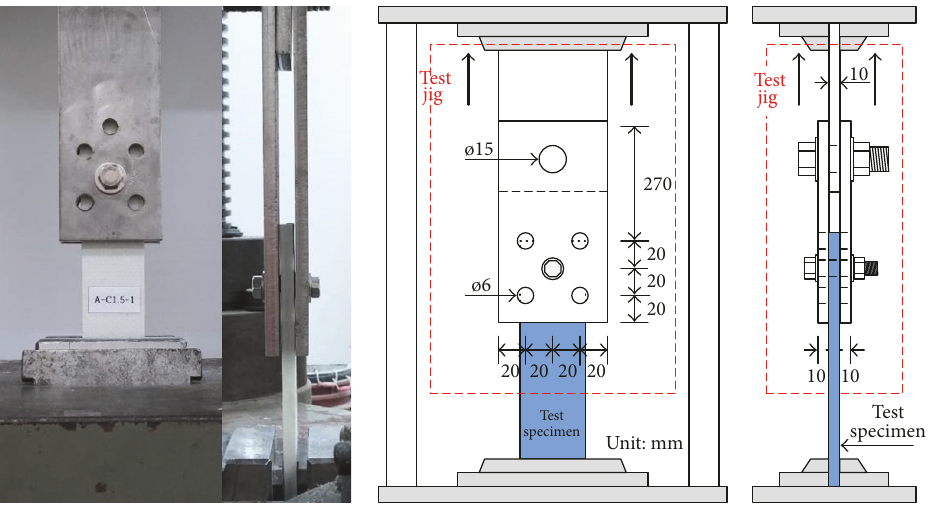
Figure 8: Tension test setup for a single-bolted connection [25].